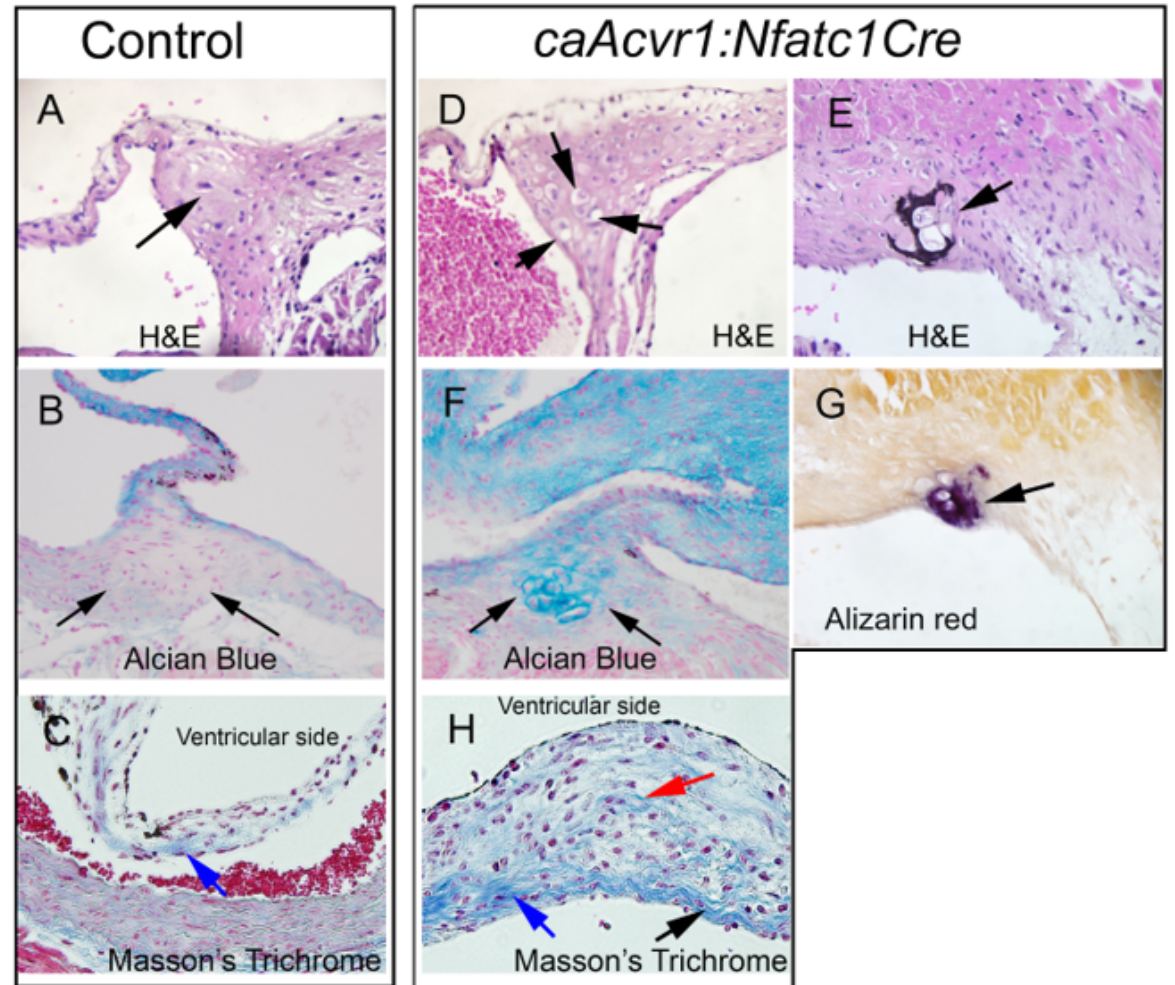
Figure 4. Chondrogenic changes and sporadic calcification in the aortic valve leaflet–wall junction region in the Acvr1:Nfatc1Cre mutants. ( A – C ) Aortic leaflet and the leaflet–wall junction in the con- trols. ( D – H ) Aortic leaflet and the leaflet–wall junction in the caAcvr1:Nfatc1Cre mutants. ( A , D , E ) H&E staining. ( B , F ) Alcian Blue staining. ( C , H ) Masson’s trichrome. ( G ) Alizarin Red staining. Ar- rows in ( A , D ) point to the leaflet–wall junction, where hypertrophic chondrocyte-appearing cells can be seen in the mutants ( n = 6). Arrows in ( B , F ) point to the leaflet–wall junction, which was stained positive for Alcian Blue in the mutants ( n = 6). Arrows in ( C , H ) point to the fibrillar collagen- positive fibrosa layer, which appears much thicker in the mutants ( n = 6). Arrows in ( E , G ) indicate calcific lesions in the mutant sample.